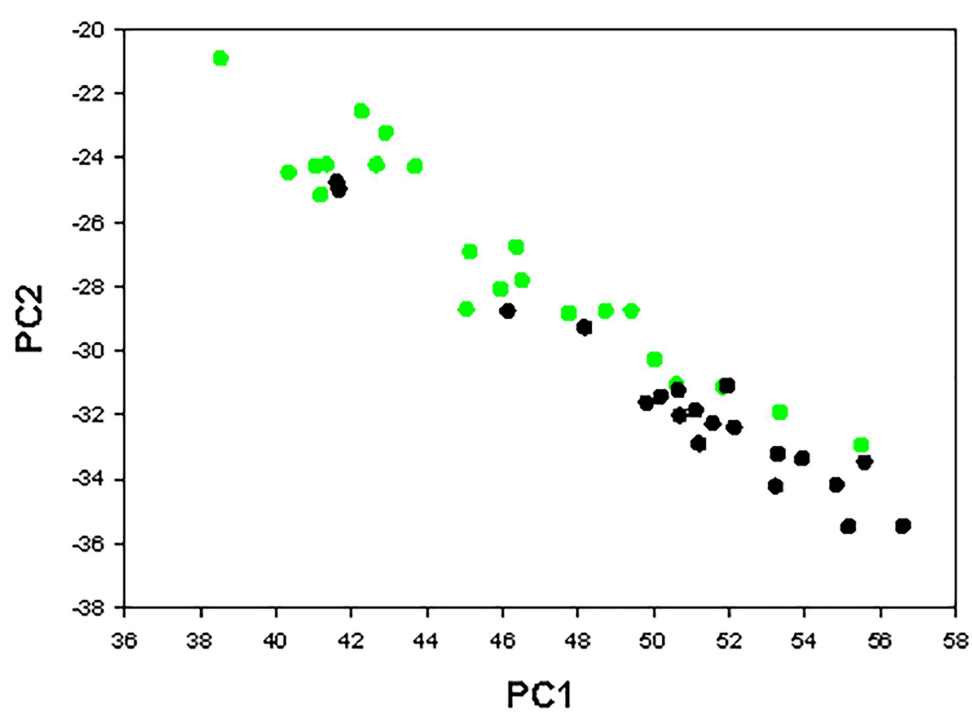
Fig 11. Principal Component Analysis Plot. Principal component plot of mice fed high-fat and control diets. Each dot represents an individualmouse. Mice fed the control diets are the green circles and mice fed the high- fat diets are the black circles. PC1 “Size-like” vs. PC2 “Ductility-like”.